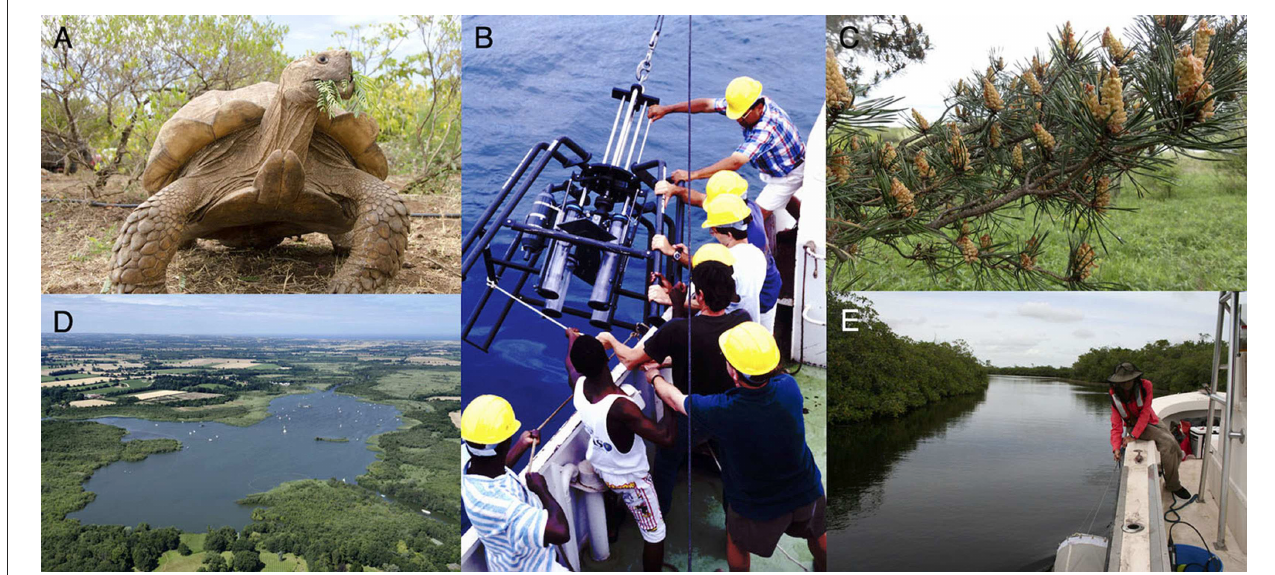
FIGURE4 “Bright spots” examples of conservation paleobiology in action. (A) At Makauwahi Cave Reserve on Kaua‘i in the Hawaiian Islands, USA giant tortoises such as this African spurred tortoise ( Centrochelys sulcata ) act as surrogates for long-lost ecological functions by helping keep invasive grasses and weeds grazed down in securely fenced native plant restorations; photo credit: A. Burney. (B) Researchers deploying a Hedrick-Marrs Multicorer to capture sediments in Lake Tanganyika, Africa’s oldest and deepest lake. The sediment cores, containing fish bones and scales, help decipher drivers of fish declines; photo credit: A. Cohen. (C) In Ireland, it was thought that Scots pine ( Pinus sylvestris ) became extinct, but fossil pollen and pine needle macrofossils demonstrate that a rare stand of Scots pine has persisted locally for centuries and is now used as a seed source for restoration efforts; photo credit: R. A. Nonenmacher; Wikimedia Commons. (D) Barton Broad is a shallow, eutrophic lake in the UK where management has targeted limiting nutrient and sediment influx from surrounding agricultural point sources. Plant macrofossil data from lake sediment cores suggest that only after reducing nutrient levels and providing habitat structure will aquatic vegetation recolonize; photo credit: John Fielding; Wikimedia Commons. (E) United States Geological Survey (USGS) researcher collecting living freshwater snails rafting out into the estuary by doing a plankton tow in Roberts River, Everglades National Park, Florida, USA; photo credit: USGS. The data on living mollusks from the plankton tows are compared to species abundances in sediment cores from the region to estimate past salinity